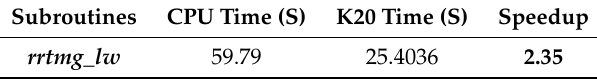
Table 5. Runtime and speedup of the G-RRTMG_LW on one GPU when compared to its counterpart running on 10 CPU cores of an Intel Xeon E5-2680 v2. Here, the block size = 512 and ncol = 2048; inatm and rtrnmc are with an acceleration in the g - point dimension; cldprmc is with a 1D decomposition; setcoef and taumol are with a 2D